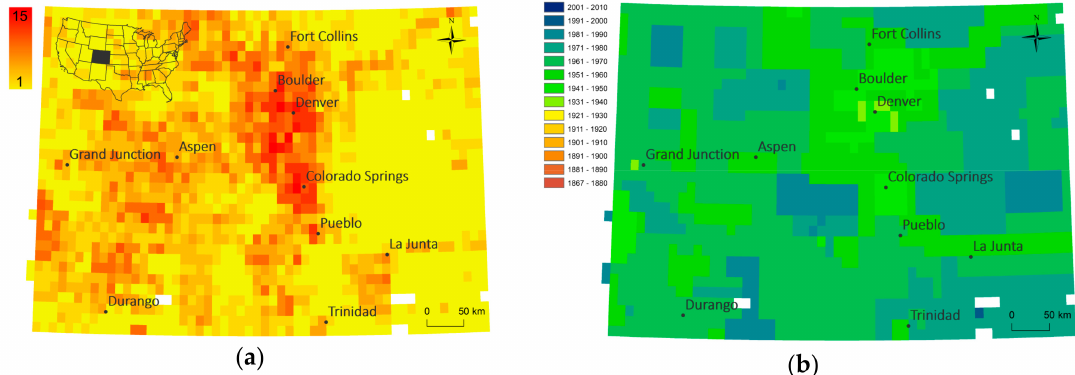
Figure 6. ( a ) Map edition counts and ( b ) earliest map production year per 1:24,000 map quadrangle in the state of Colorado (USA) based on metadata analysis.